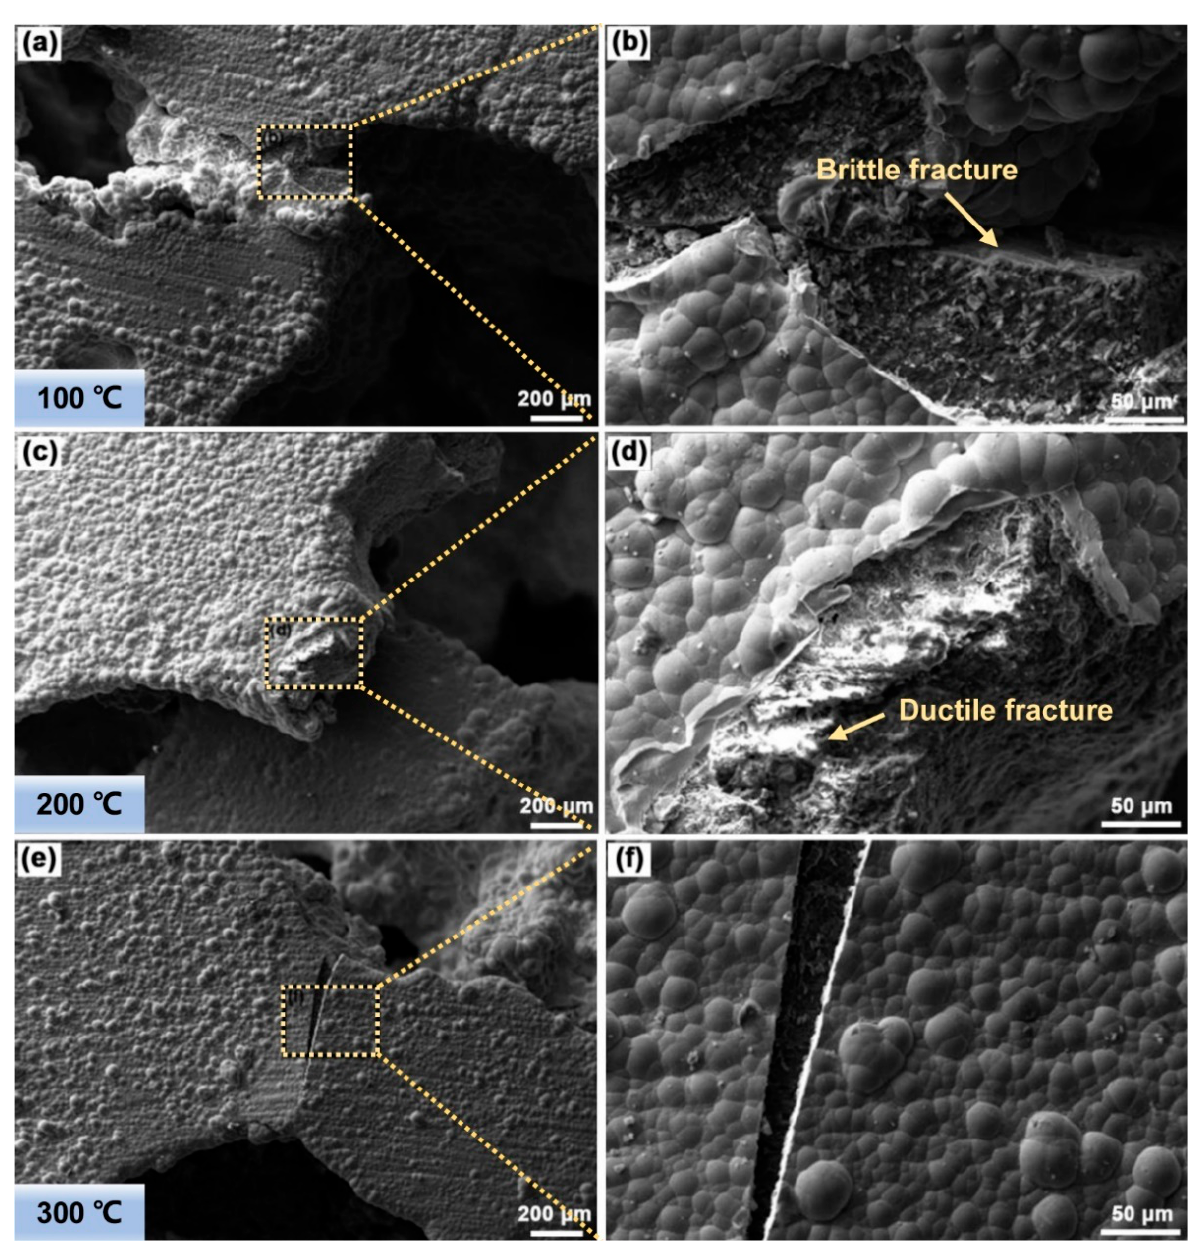
Figure 11. The fracture morphologies of AZ91D hybrid foams at temperatures of ( a ) 100 °C, ( c ) 200 °C and ( e ) 300 °C; ( b , d , f ) are high magnification images for ( a , c , e ), respectively.